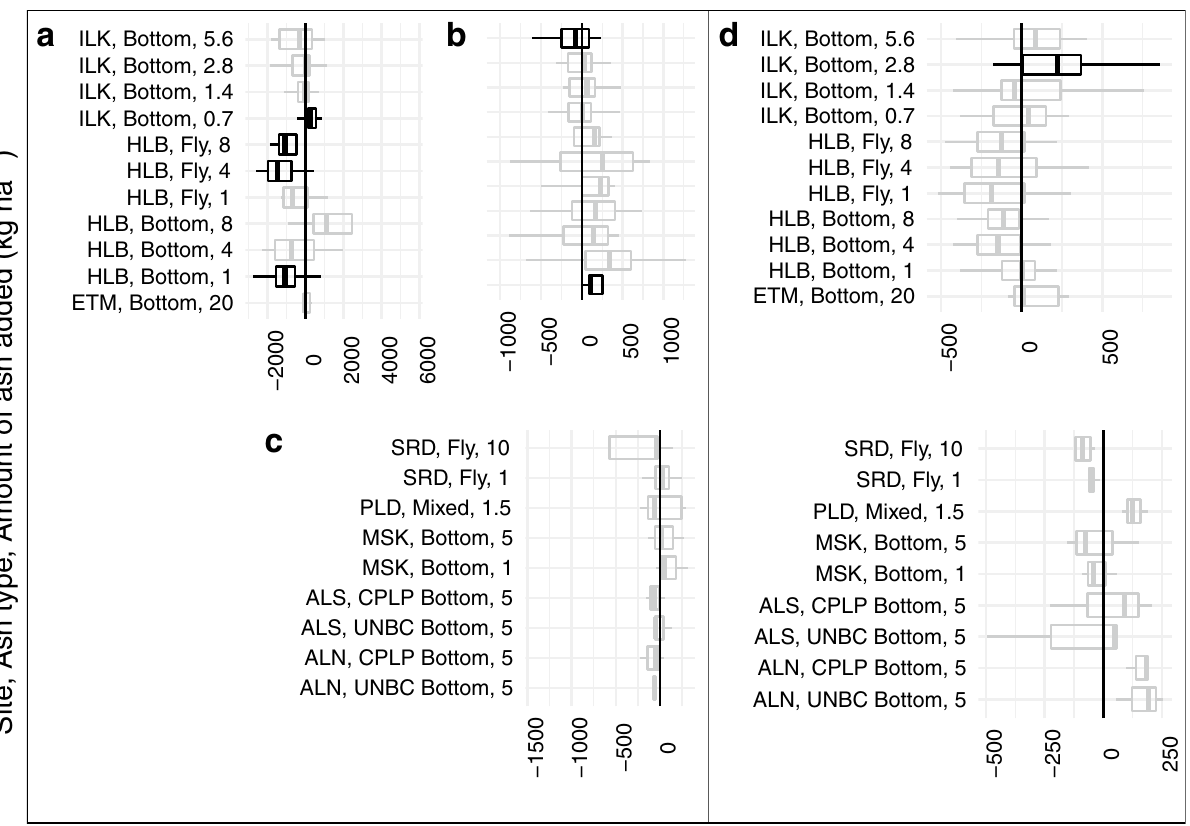
Figure 4. Differences in phosphatase activity between treatments and controls. Results significantly different than zero as determined by Wilcoxon-test are shown ( p < 0.05), results that were not significant are shown with . Panels show different soil horizons a = L, b = FH, c = LFH, d = 0–10 cm of mineral soil. No responses were significant at a Bonferroni corrected α